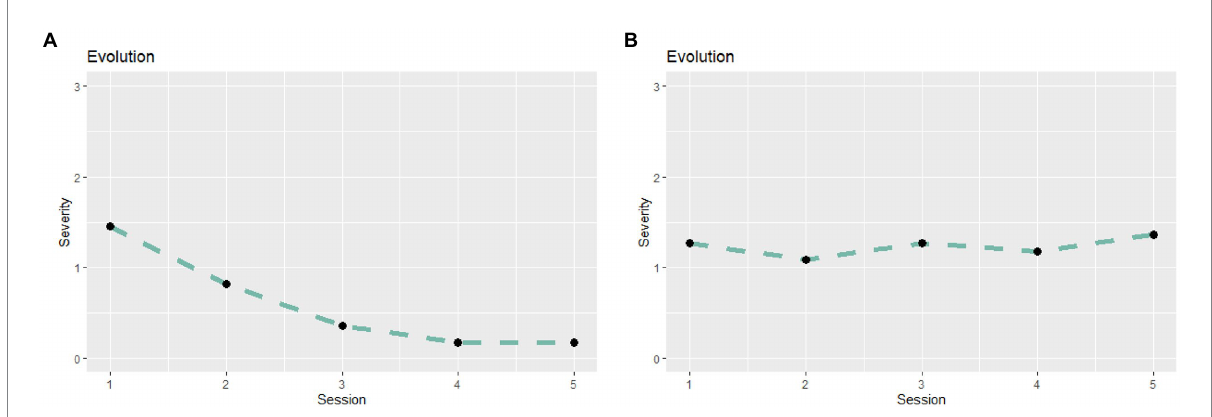
FIGURE 2 Examples of the first plots provided to the therapists to give feedback about patients’ clinical evolution during the first five sessions. (A) presents an example of a patient who improved during the timeframe, while (B) presents the example of a patient who presented a stable pattern.